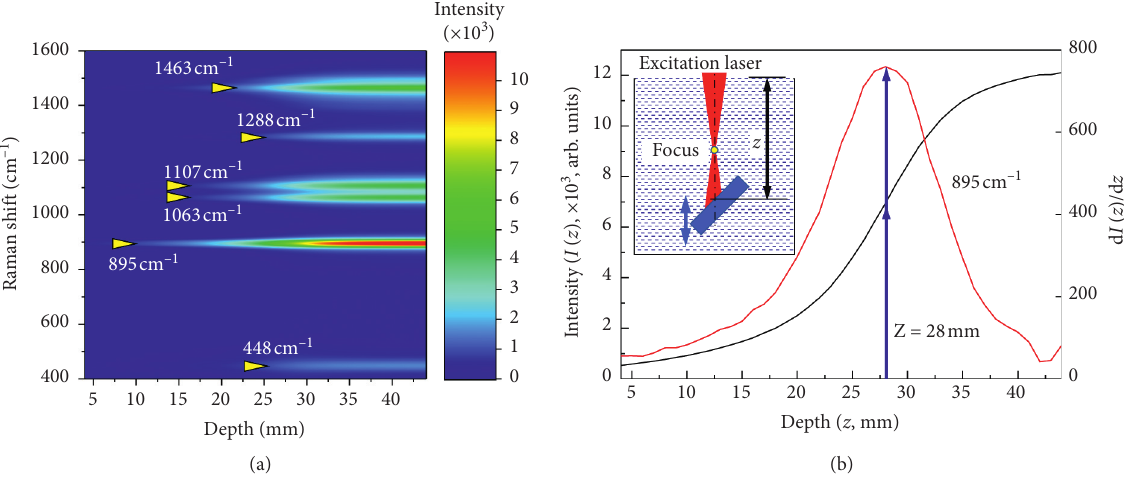
Figure 2: (a) Intensity of the Raman-scattering spectrum as a function of Raman shift and depth of the “blocking” mirror below the liquid surface, where 6 Raman peaks can be observed. (b) The Raman signal peak intensity ( I(z) ) at about 895cm − 1 varying with the depth ( z ) of the “blocking” mirror (black curve). Red curve: d I(z) /d(z), showing an inflection point roughly at the focus of the laser beam with z � 28mm. Inset: schematic illustration of the experimental setup.